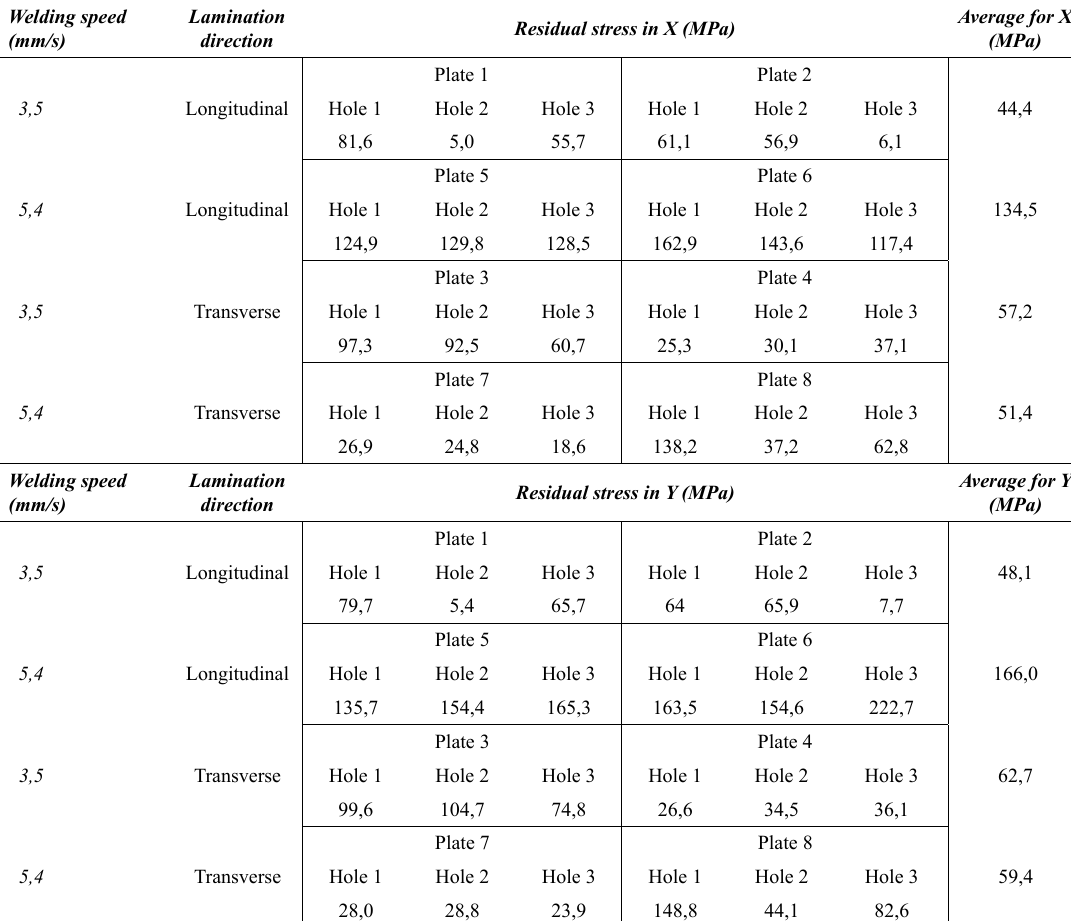
Table 3. Residual stress values calculated from the DCP method. Welding speed